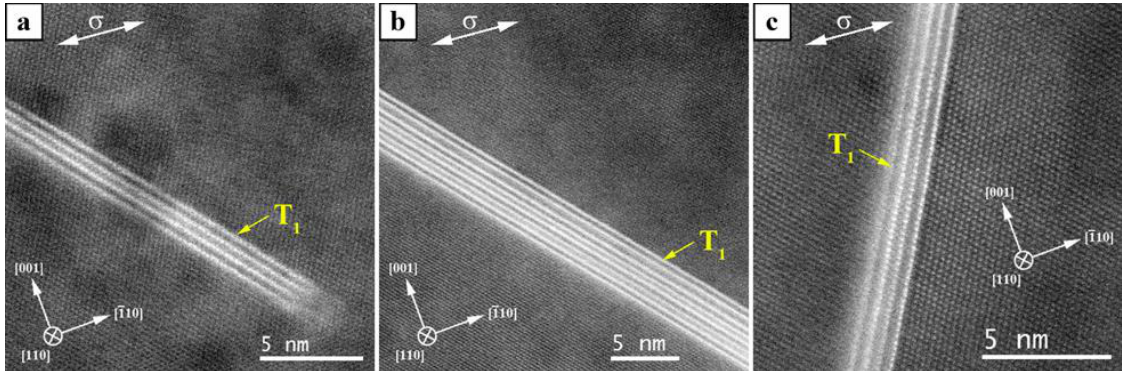
Figure 10. T 1 plates of Creep test 2 (155 MPa, 180 °C, 1002 h): ( a ) Type 2 on (1̅11) Al ; ( b ) Type 4 on (1̅11) (11̅1) Al ; and ( c ) Type 2 on Al .